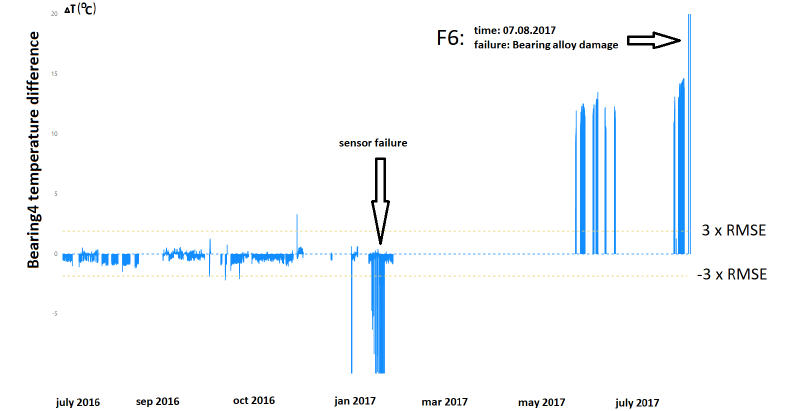
Figure 9. Difference between the real and estimated value of temperature of Bearing 4.